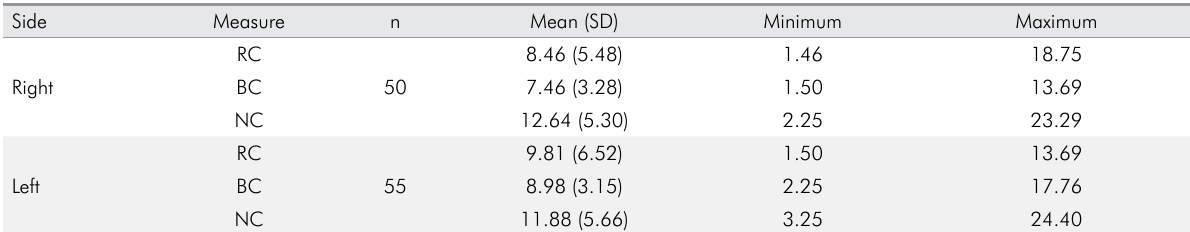
Table 4. Statistical data of the comparisons between the sides for measures RC, BC and NC for male subjects. Side Measure n Mean (SD) Minimum Right